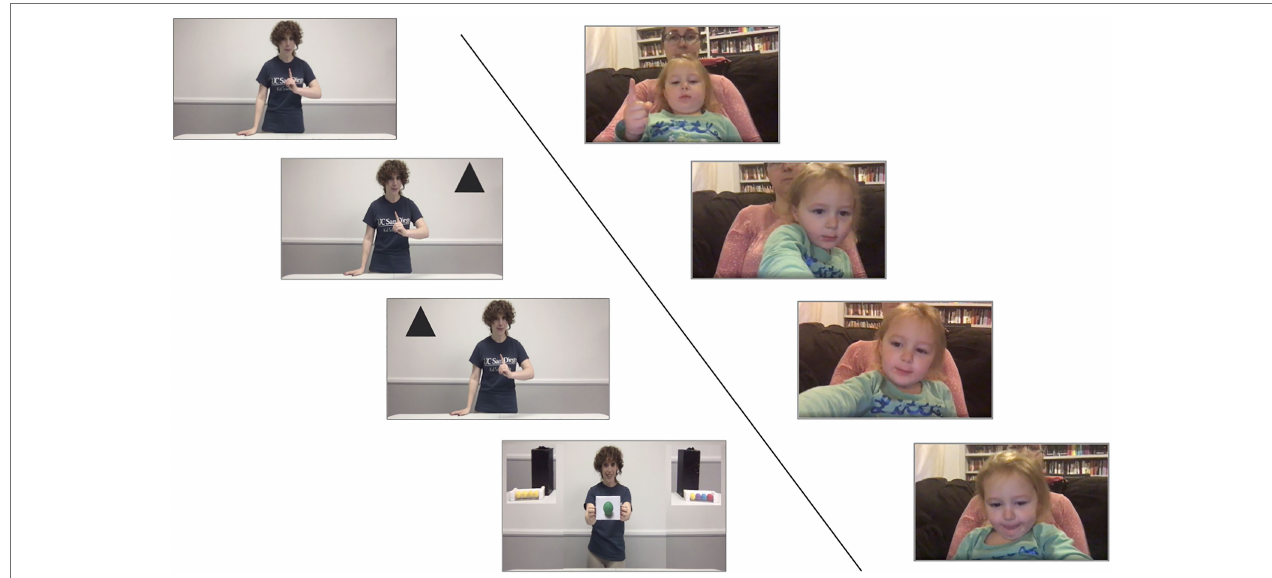
FIGURE 2 | The sequence of response events in the online versions of the task. The images to the left display the pointing events from the prerecorded video shown to participants in Experiments 2 and 3. The images to the right display a sample webcam recording of the participant during each pointing event. Complete study videos may be found at